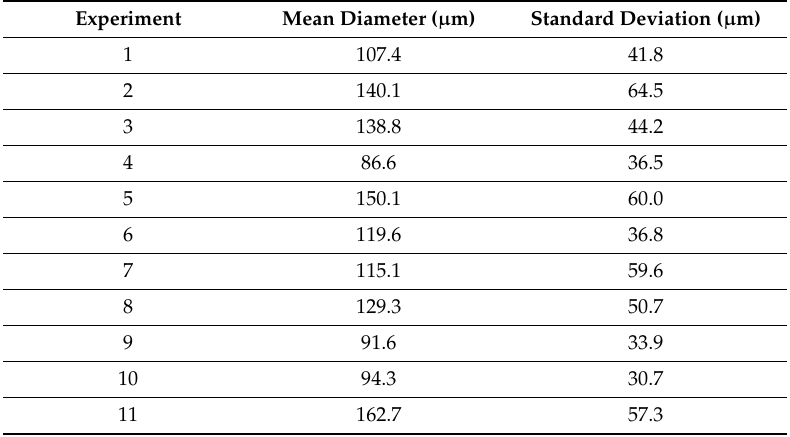
Figure 5. Size distribution of CO 2 microbubbles in Experiment No.1. Table 3. Average bubble size and standard deviation of CO 2 microbubbles dispersions.